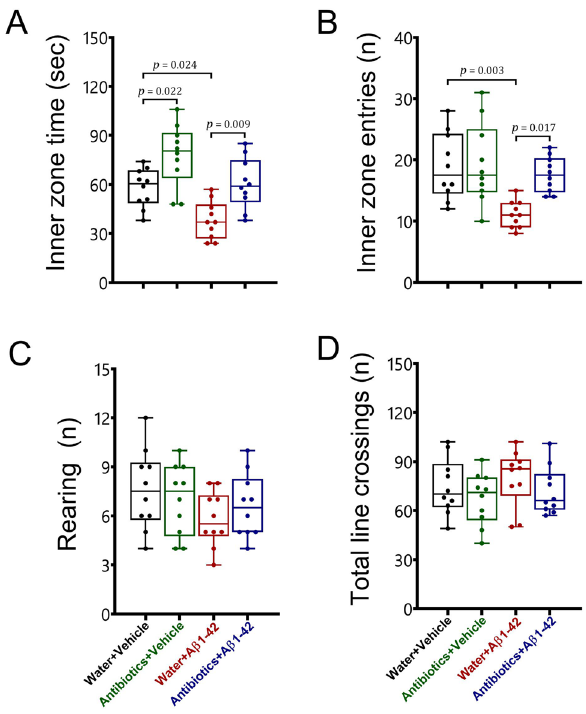
Figure 1. The effects of antibiotic treatment alone or in combination with Aβ1–42 treatment on anxiety-related behaviour in male C57BL6 mice. To assess anxiety-related behaviour ( A inner zone time; B inner zone entries) and locomotor activity ( C rearing; D total line crossings), animals were subjected to the open field test. Data are expressed as mean ± SEM (n = 10). Antibiotic treatment significantly increased the inner zone time [ p = 0.022], but it did not affect the other parameters [ p > 0.05] compared to the water + vehicle mice. On the other hand, Aβ 1–42 administration in water-treated mice significantly decreased the inner zone time [ p = 0.024] and entries [ p = 0.003] compared to the water + vehicle group. However, Aβ 1–42 injection could not affect the inner zone time and entries [ p > 0.05] in antibiotic-treated mice compared to the water + vehicle or antibiotics + vehicle groups. Besides, significant differences in all behavioural parameters in the open field test were not observed between antibiotics + Aβ 1–42 mice and water + vehicle group [ p > 0.05]. Moreover, there are significant differences in the inner zone time [ p = 0.009] and entries [ p = 0.017] between water + Aβ 1–42-treated mice and antibiotics + Aβ 1–42-treated animals. Furthermore, both antibiotic and Aβ 1–42 treatments did not change [ p > 0.05] the rearing and the total line crossings in the open field